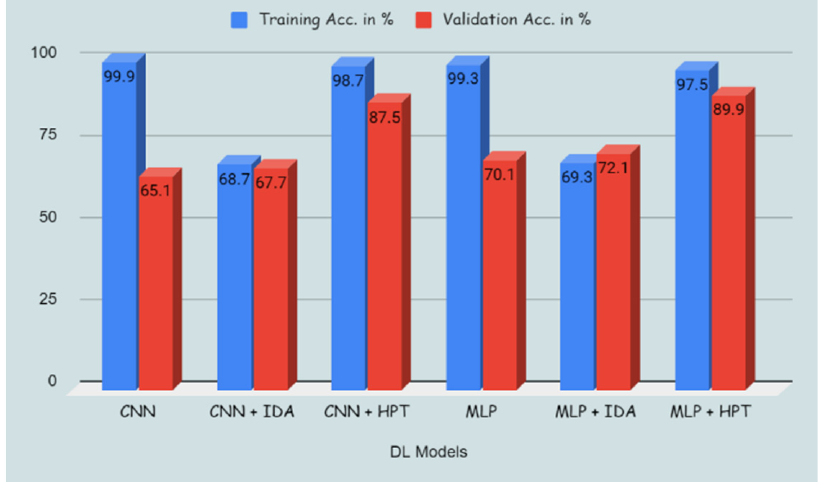
Figure 21. Deep learning models’ training and validation accuracies.